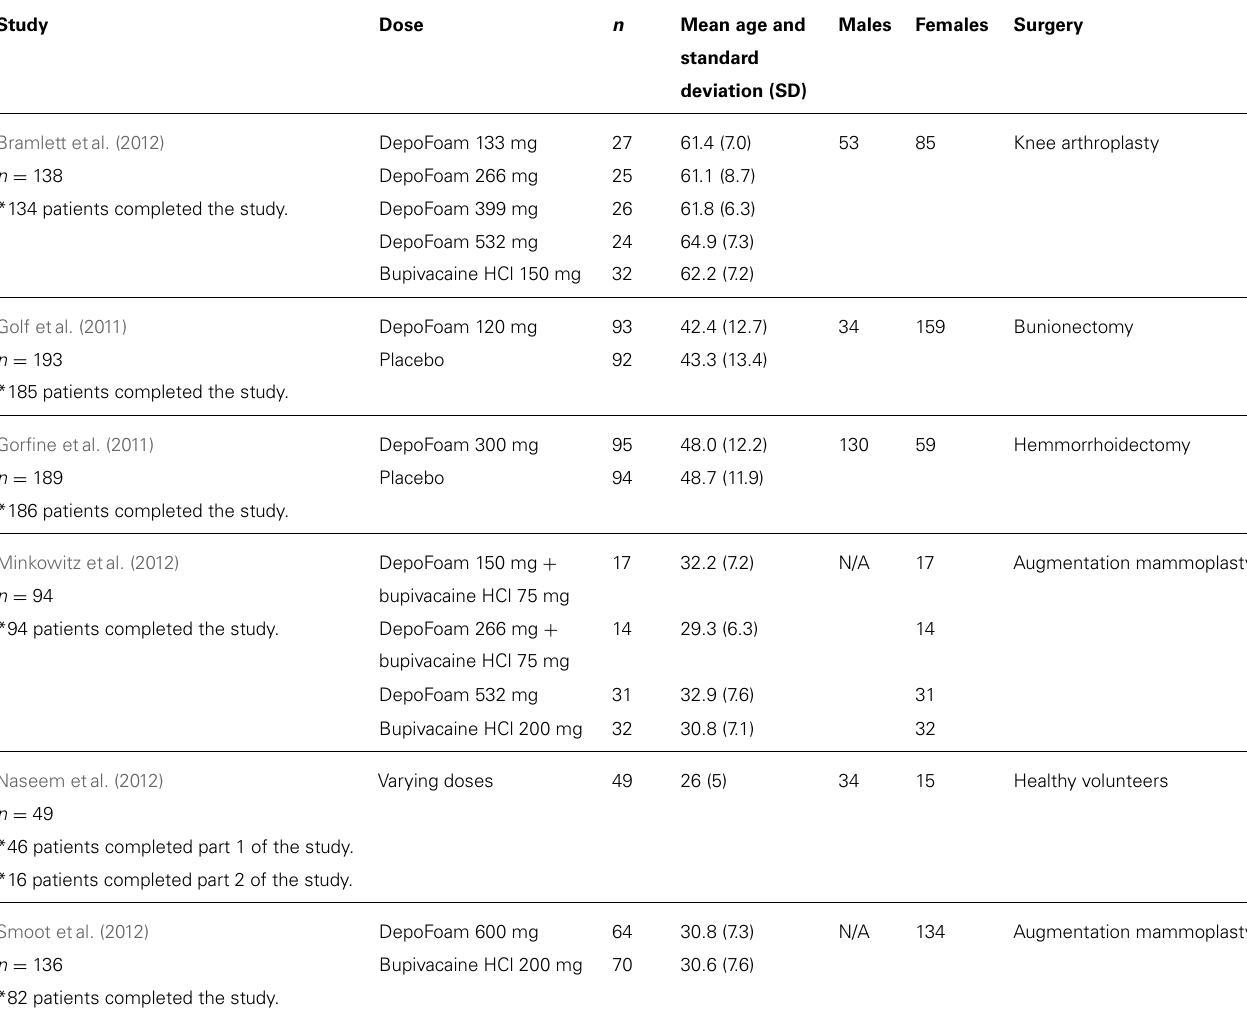
Table 1 | Randomization groups and demographic